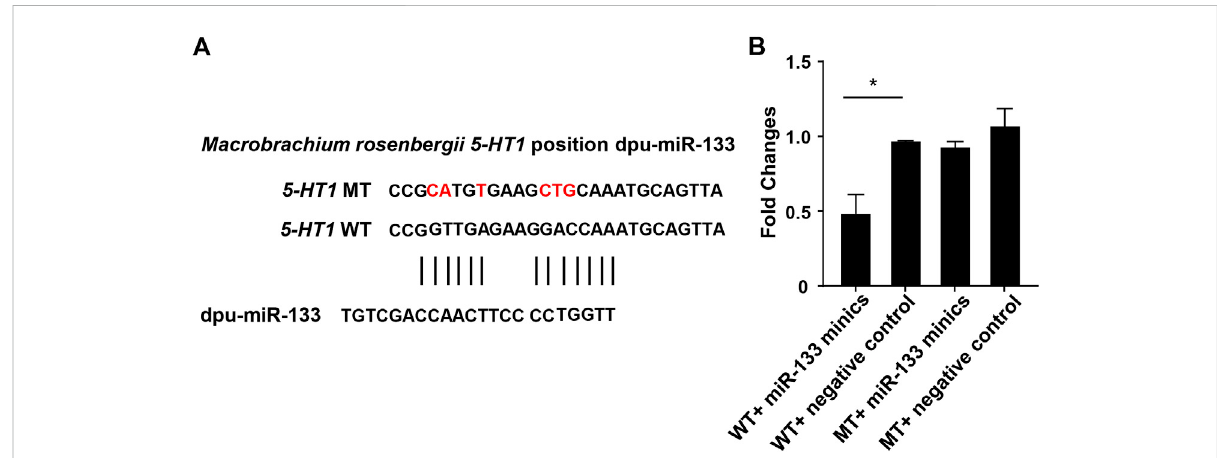
FIGURE 6 Doubleluciferasereportergeneanalysis ofmiR-133and 5-HT1 . (A) .ThebindingsiteofmiR-133to 5-HT1 3 ’ -UTR. (B) .Relativeluciferaseactivity inHEK293cells.GraphPadPrism7drawsahistogram.Themeans±standarddeviationsofthethreeindependentexperimentsareshowninthedata. * p <